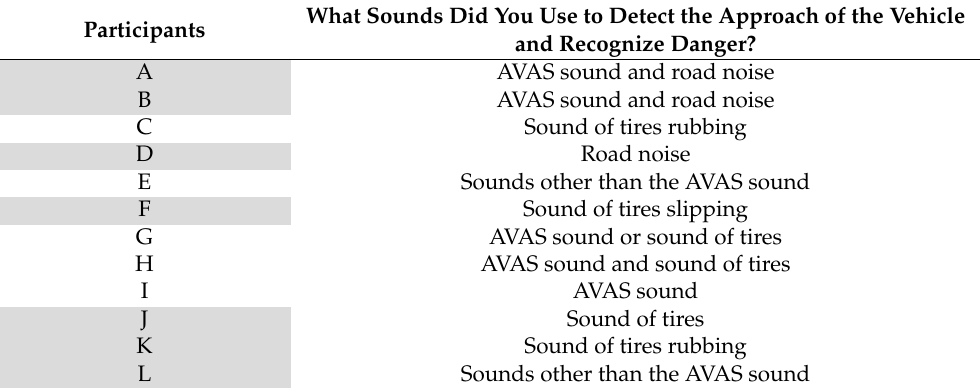
Table 4. Sounds that the participants used to detect the approach of the quiet vehicle after the design-of-awareness